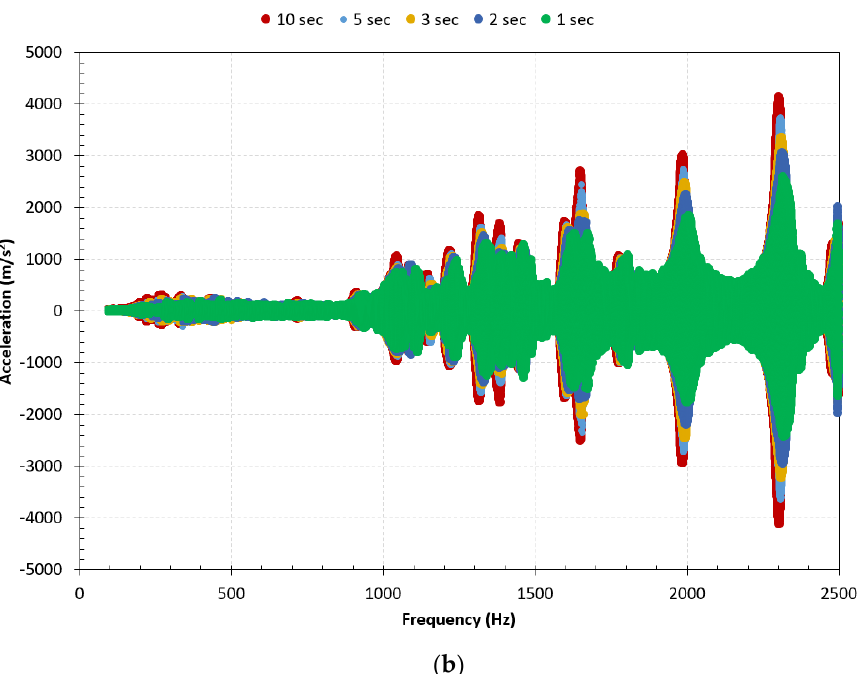
Figure 3. Acceleration at the plate’s end for a frequency sweep of 100 Hz to 2500 Hz at 200 Vpp for piezoelectric actuator 4 ( a ) and actuator 5 ( b ).